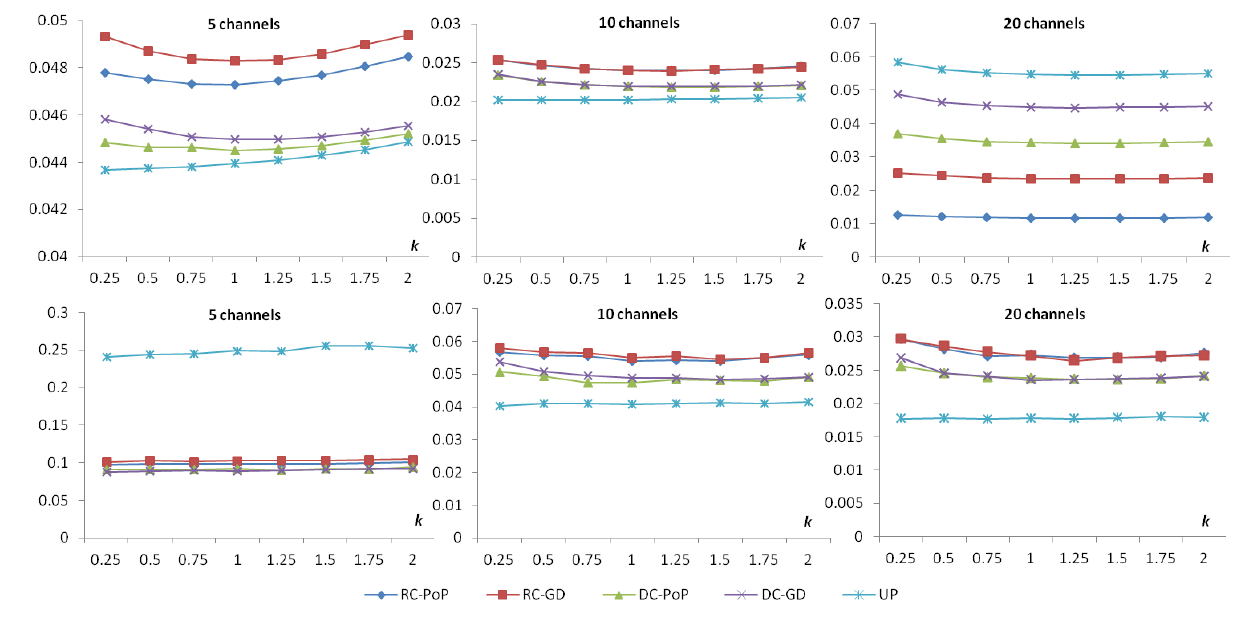
[sec 2 ] vs randomization coefficient k , first row: same channel ranking case, second row: irdv